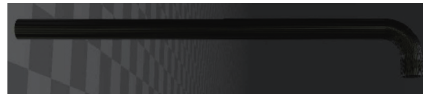
Figure 21: Goose neck pipe.